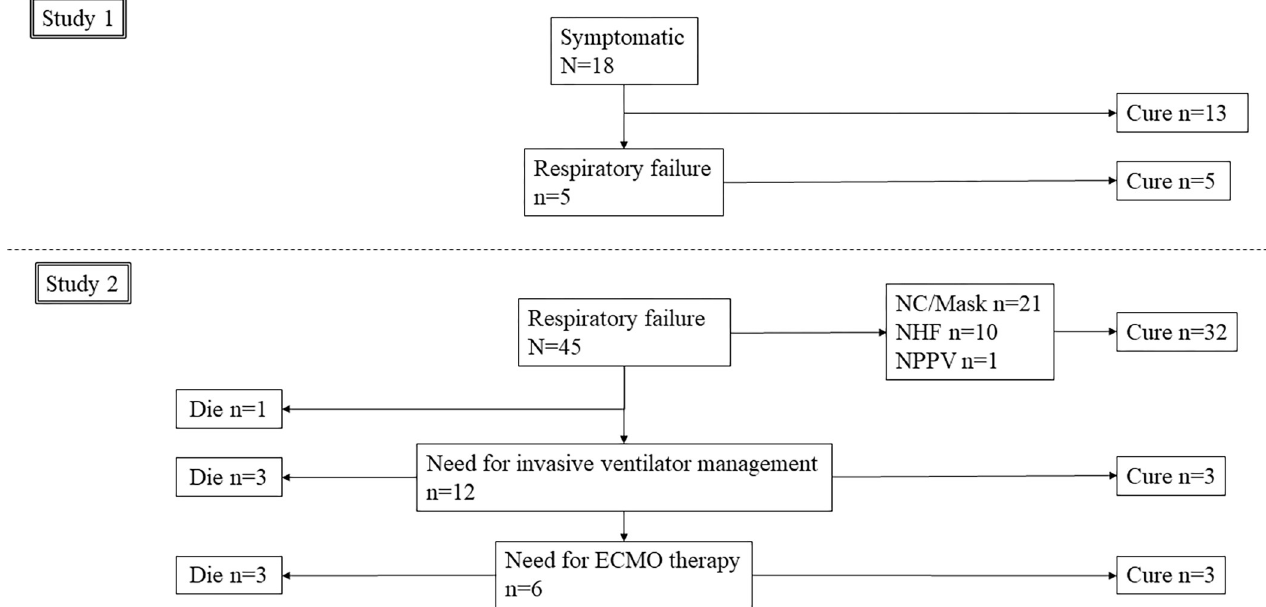
Fig 2. Clinical outcomes of eligible patients. NC: nasal canula, NHFC: Nasal high-flow cannula, NPPV: Non-invasive positive pressure ventilation, ECMO: Extracorporeal membrane oxygenation.